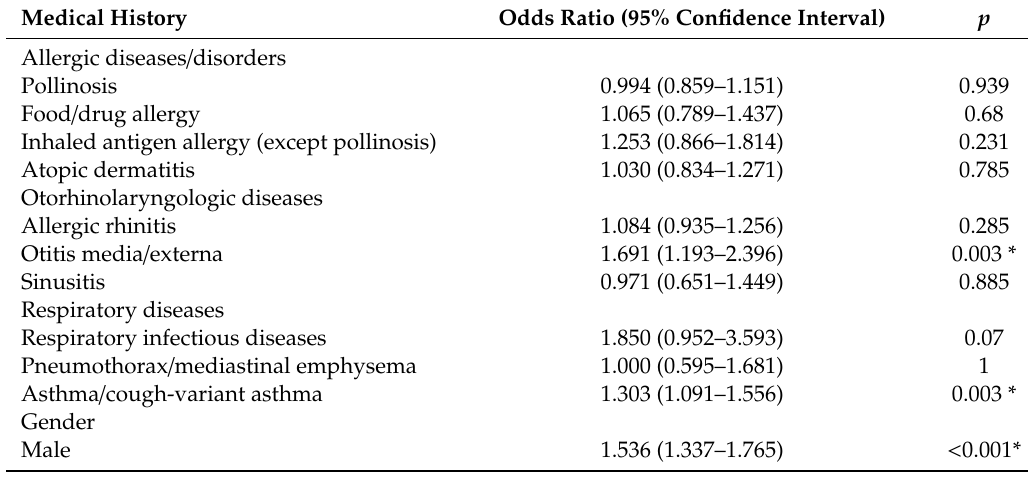
Table 3. Multivariate analysis for the association between gum bleeding and medical